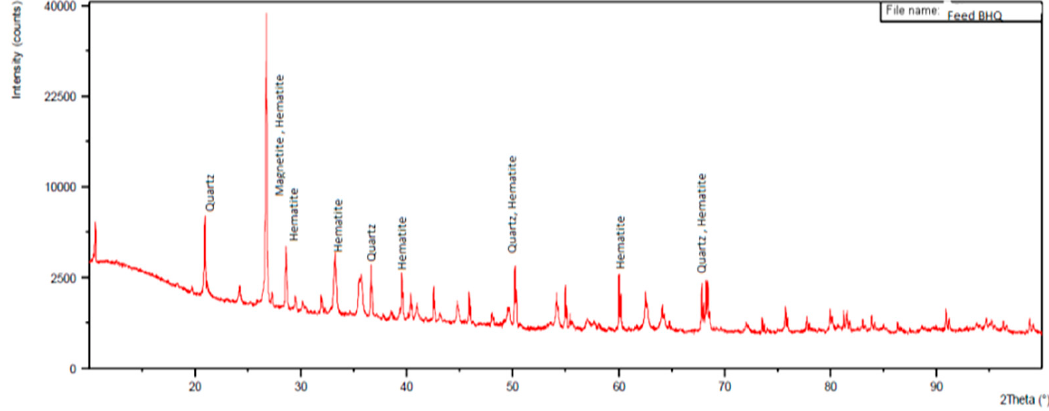
Figure 3. XRD of feed showing the presence of hematite and quartz.